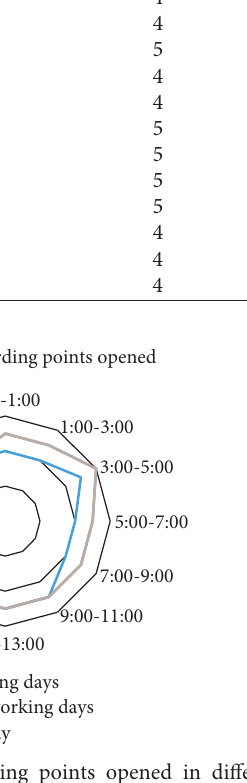
Table 14: The number of boarding points opened in different periods in the airport. Observing session Working